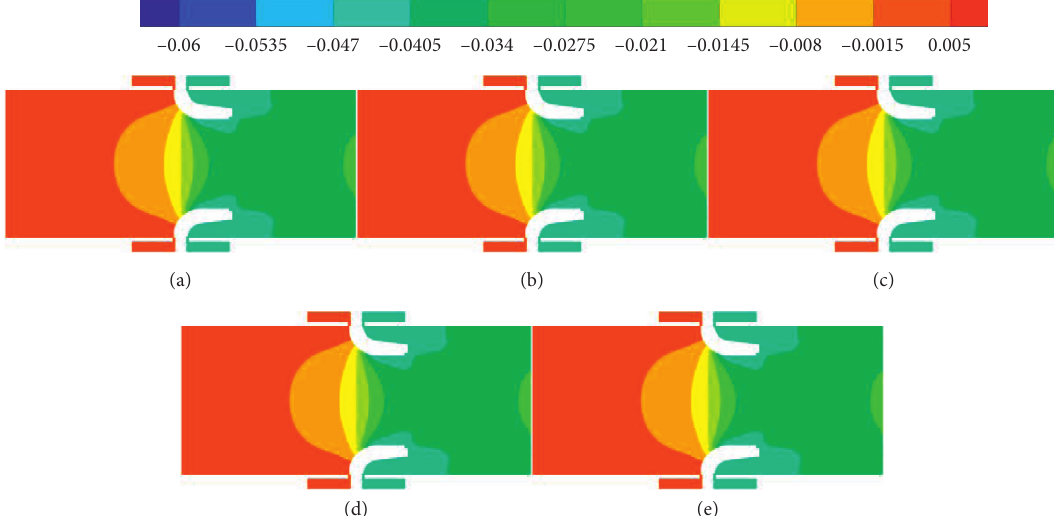
Figure 13: Pressure field distribution of cross section in flow meter (10m 3 /h). (a) 50 ° C. (b) 100 ° C. (c) 300 ° C. (d) 500 ° C. (e) 700 ° C.